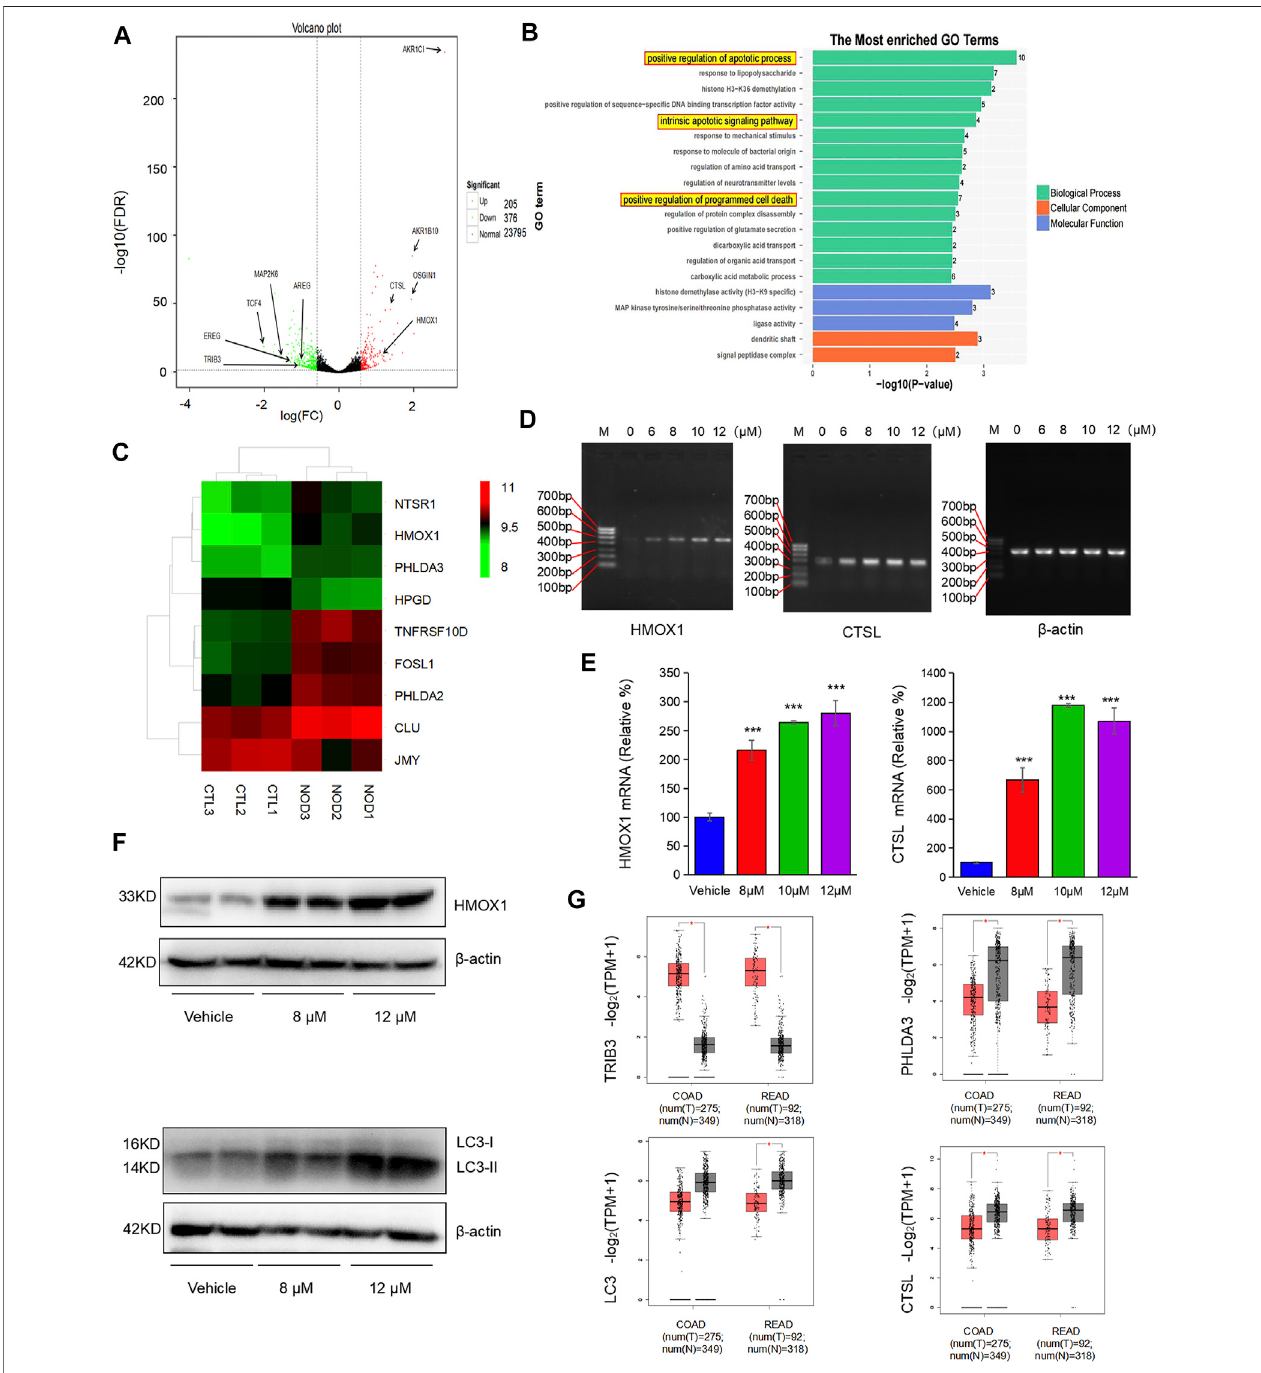
FIGURE 5 | Transcripptomic results demonstrated that nodosin induced oxidative stress, apoptosis, and autophagy. (A) Voclano plot of the differential genes between the nodosin treated and control groups. (B) GO analysis enriched for biological processes with more obvious differential gene changes, with more differential genesinbiologicalprocessesrelatedtoapoptosis. (C) Heatmapofthedifferentialgenesassociatedwithapoptosisbetweenthenodosintreatedandcontrolgroups. (D) The cDNA levels of HMOX1 , CTSL , and β -actin were measured by PCR. (E) The mRNA levels of HMOX1 , CTSL , and β -actin were detected by q-PCR. Each test wasrepeatedthreetimes,andthedifferencewastestedbyatwo-tailed t -test.* p < 0.05,** p < 0.01,*** p < 0.001. (F) TheproteinlevelsofHMOX1, β -actin,andLC3were tested by western blotting. (G) Expression of the oxidative stress, apoptotic and autophagy-related genes TRIB3 , PHLDA3 , LC3 , and CTSL in clinical CRC and normal tissues (http://gepia.cancer-pku.cn/index.html, COAD: Colon adenocarcinoma; READ: Rectal adenocarcinoma, * p < 0.05).